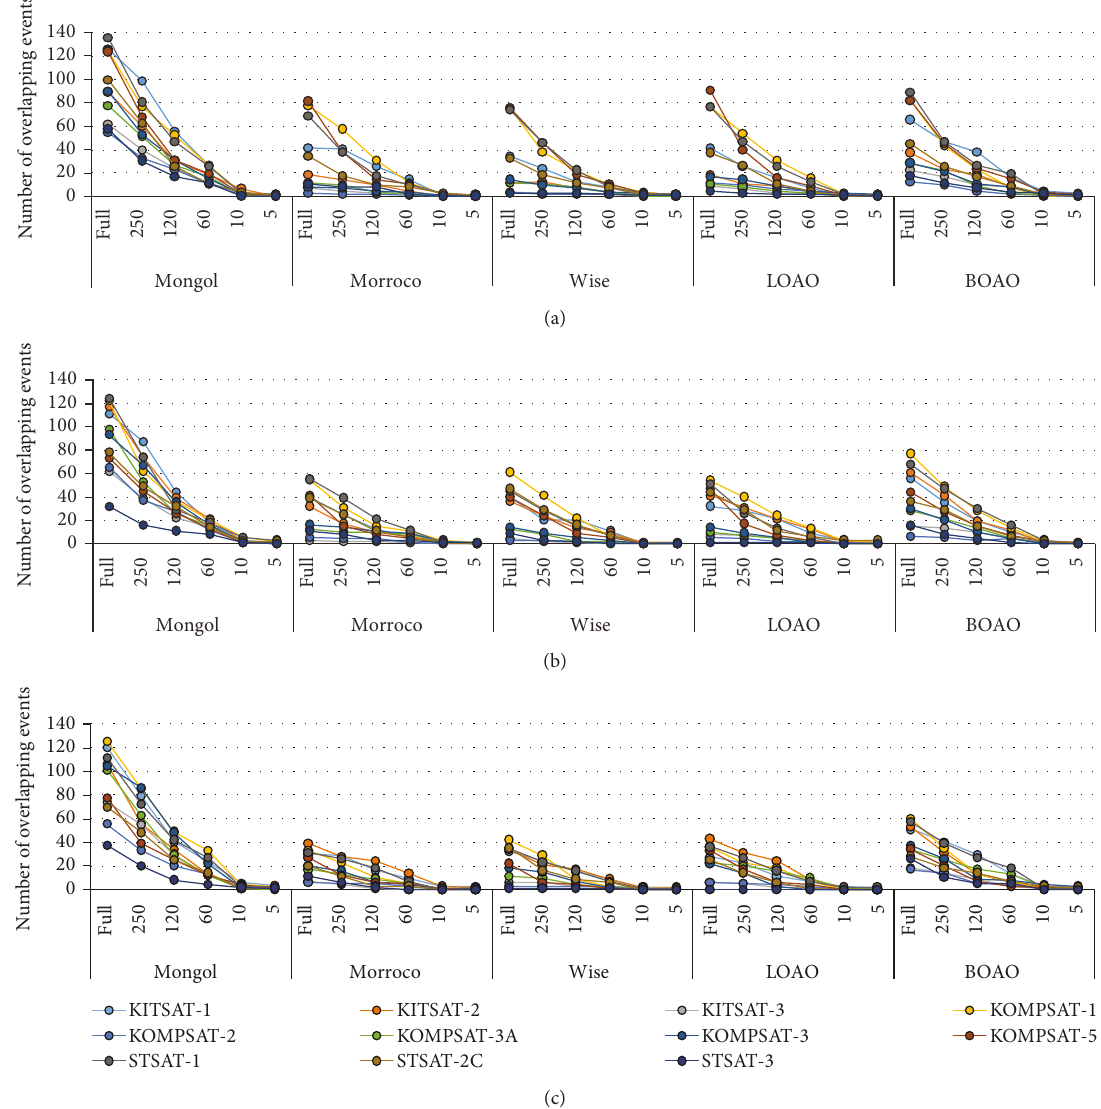
Figure 5: Variation of number of overlapped events for the 11 LEO observation targets for normal cases (full) and fi ve short-arc strategies from 2014 to 2016 ((a) 2014, (b) 2015, and (c)